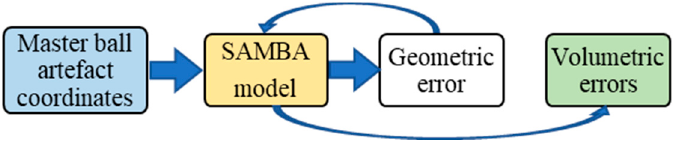
Figure 4. General steps of SAMBA method for VE estimation.